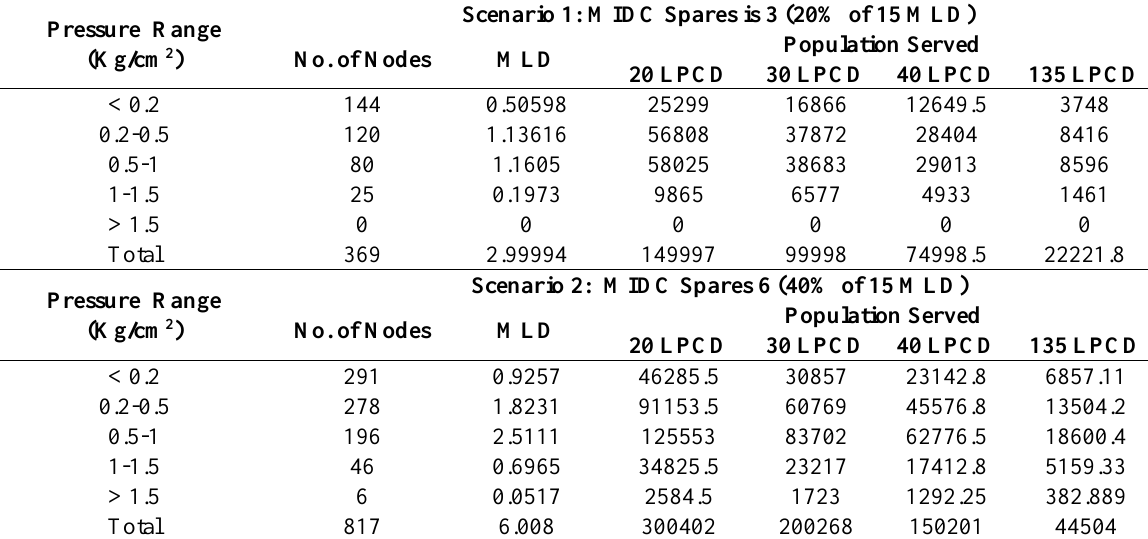
Table 2. Comparison of the results of 2